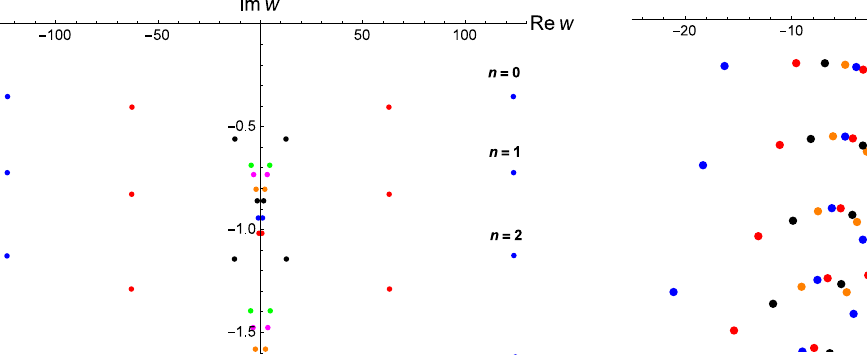
Fig. 8 The QNMs w = ω r h ( r h ∈ ( 0 . 25 , 5 . 8 )) of dRGT black string with M = 1 ,α g = 1 ,(cid:14) = 0 ,(cid:15) = − 0 . 01 ,λ = k = 0 , m = 0 and γ = 0 . 1 , 0 . 2 , 0 . 4 , 0 . 7 , 1 , 2 , 3 , 5 , 10 , 20 , 60 (presented by colored dots from the vertical axis out to both sides) for N =